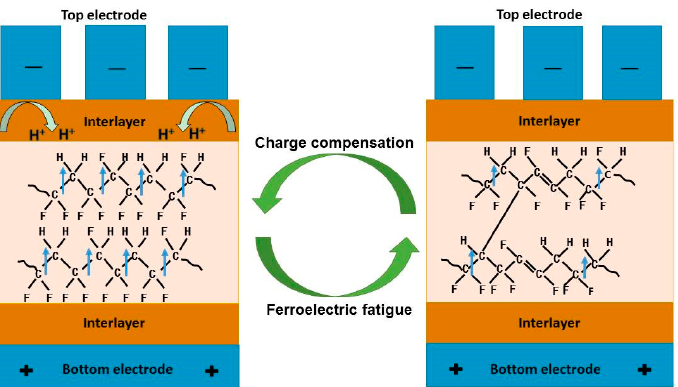
Figure 5. Schematic diagram of the polarization state of P(VDF–TrFE) thin films in ferroelectric capacitors, including the processes of charge compensation and ferroelectric fatigue.